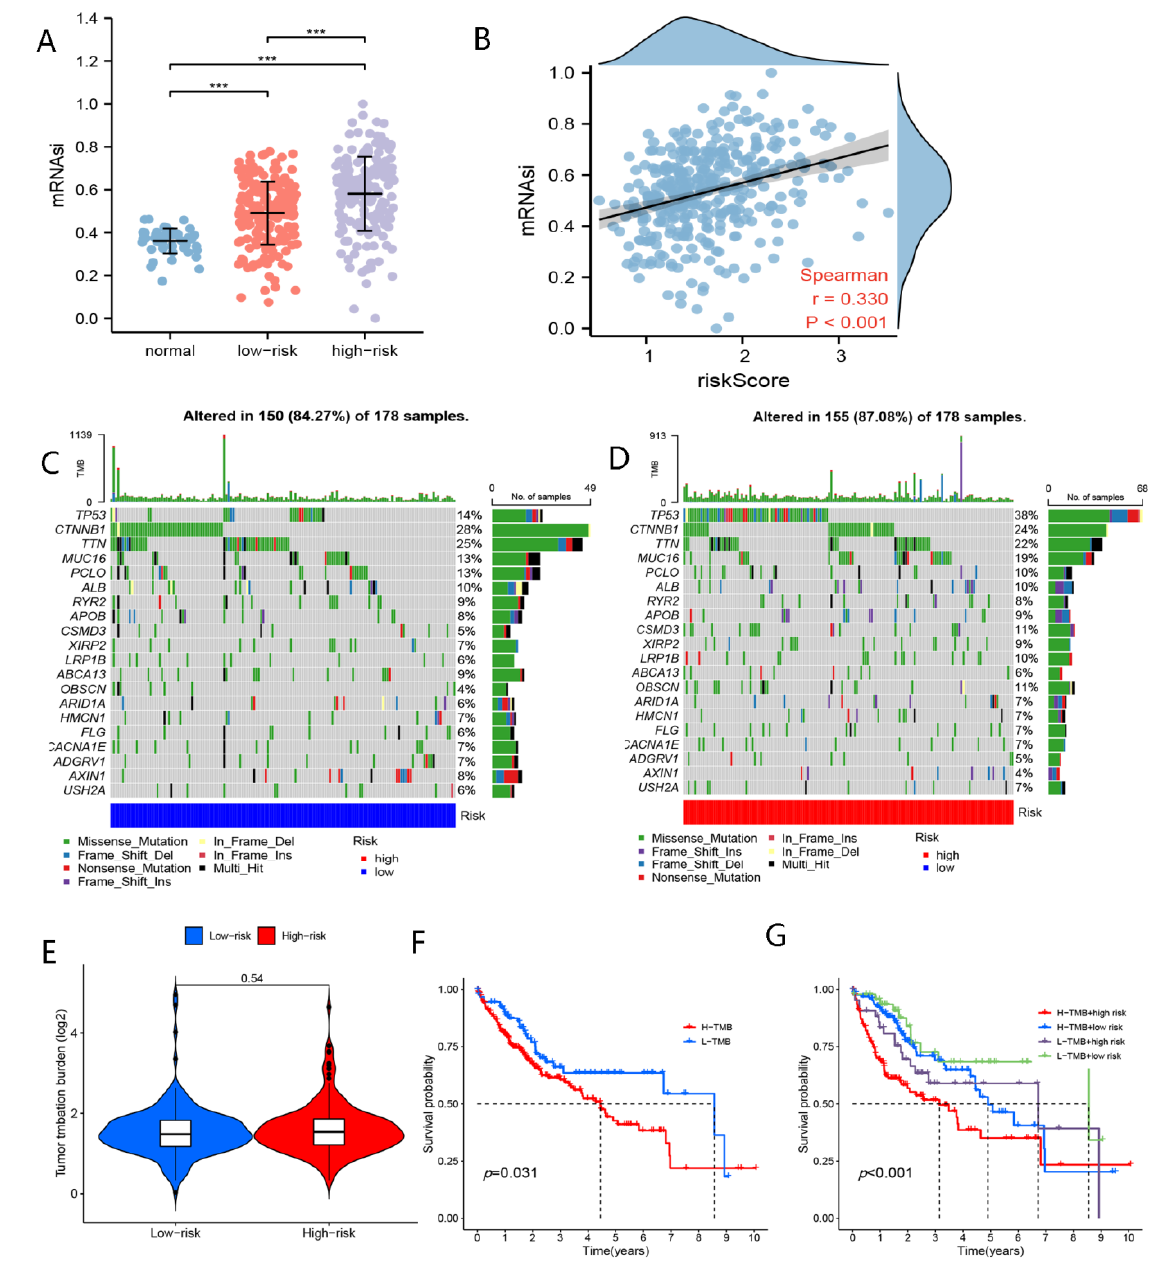
Figure 8. Stemness index and somatic mutation analyses. ( A ) Comparison of mRNAsi in the low- and high-risk groups. ( B ) Correlation between risk score and mRNAsi. ( C ) Waterfall plot for the top 20 mutated genes in the high-risk group. ( D ) Waterfall plot for the top 20 mutated genes in the high-risk group. ( E ) Comparison of TMB in the high- and low-risk groups. ( F ) KM curve of TMB. ( G ) KM curve of TMB + nFRGs. (*** representing p < 0.001).